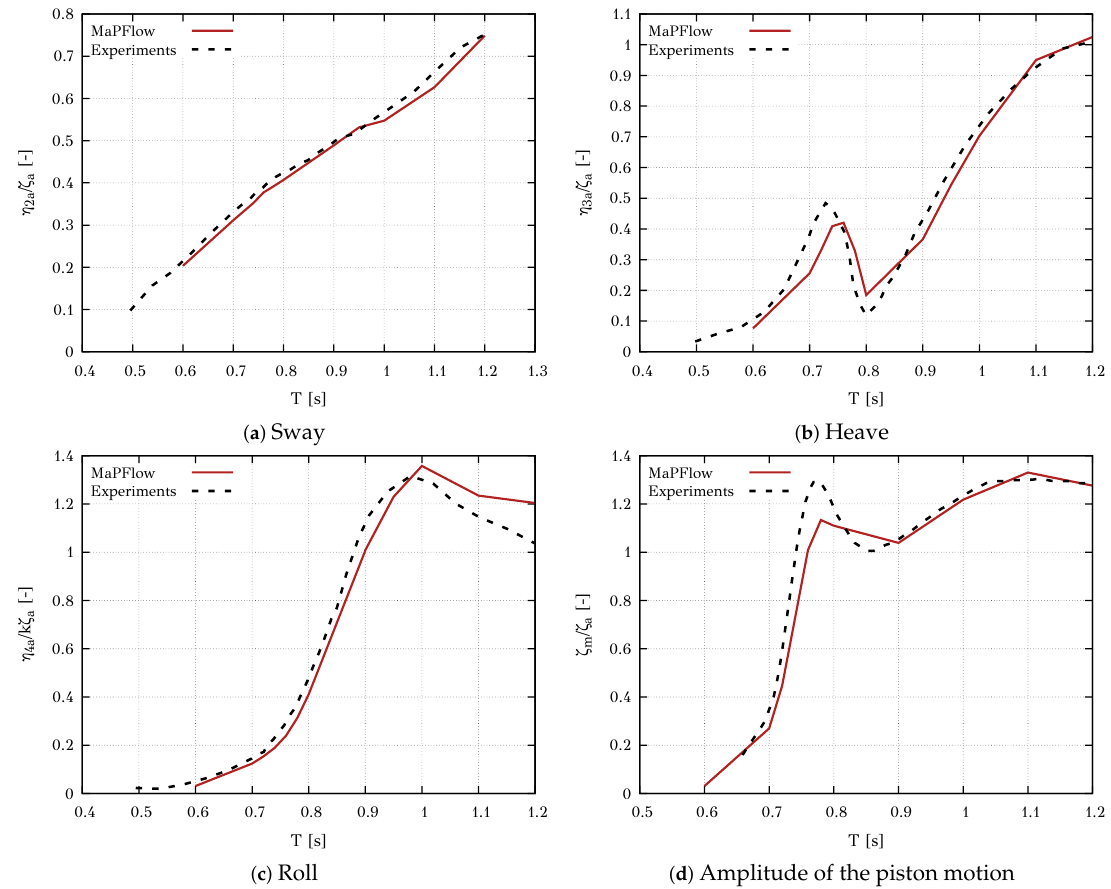
Figure 10. RAOs of the three motion and the space averaged free surface elevation inside the moonpool for wave steepness H / λ = 1/30. ζ a is the amplitude of the incoming wave.